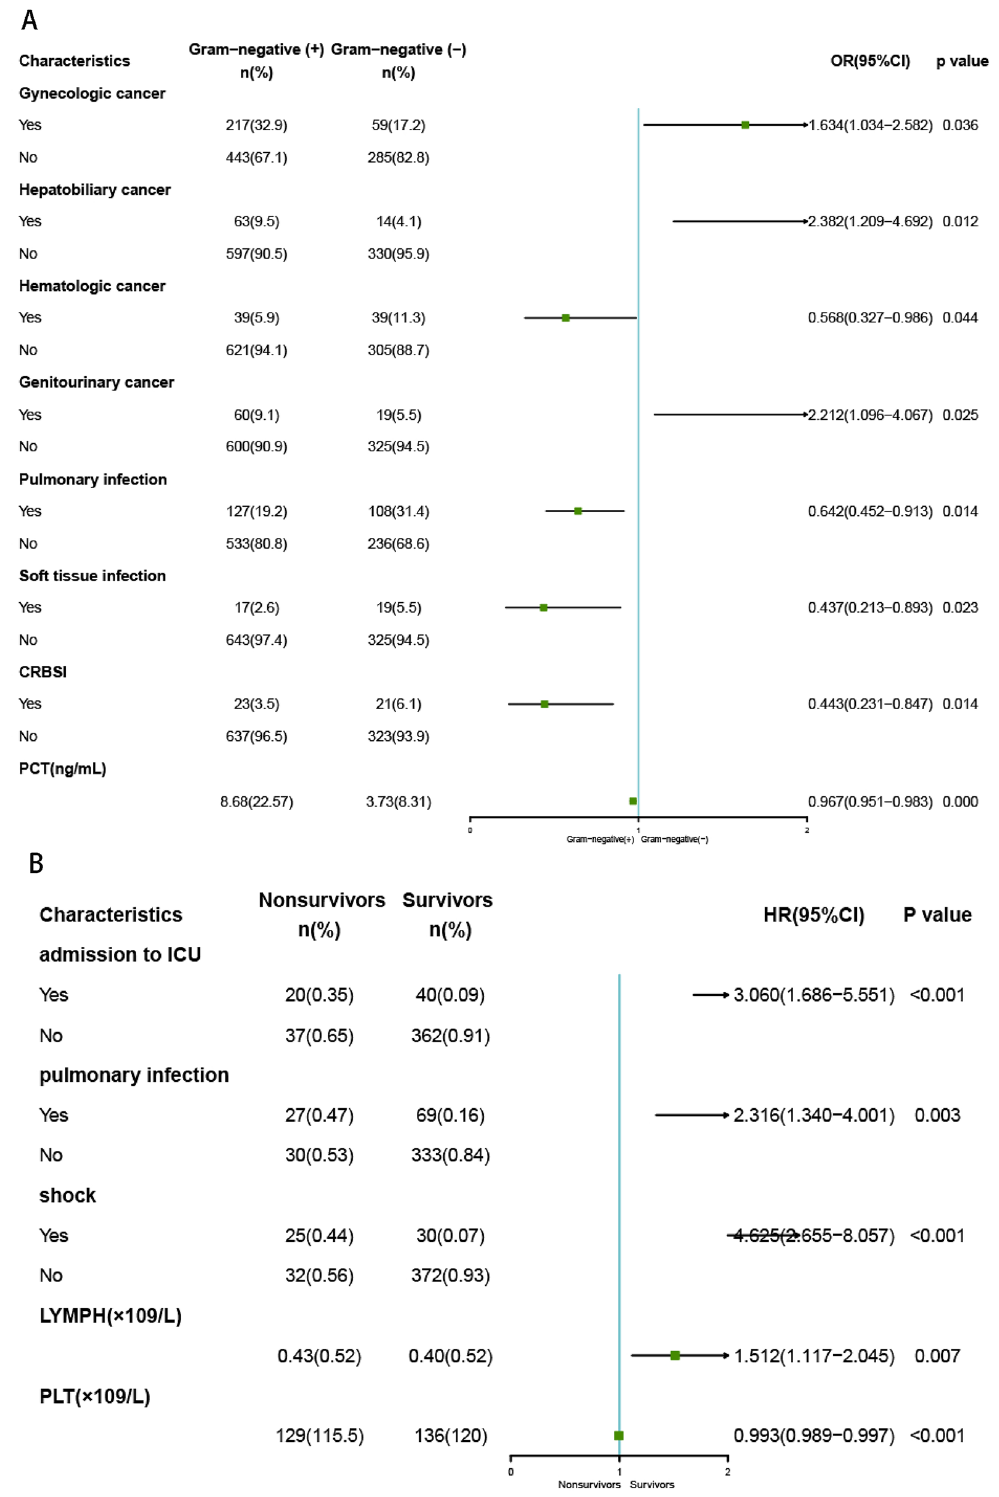
Figure 2. Forest plots showing the multivariate analysis results. Logarithmic odds ratios for GNB infection ( A ). Cox proportional hazards regression model for surviors in malignant patients with GNB ( B